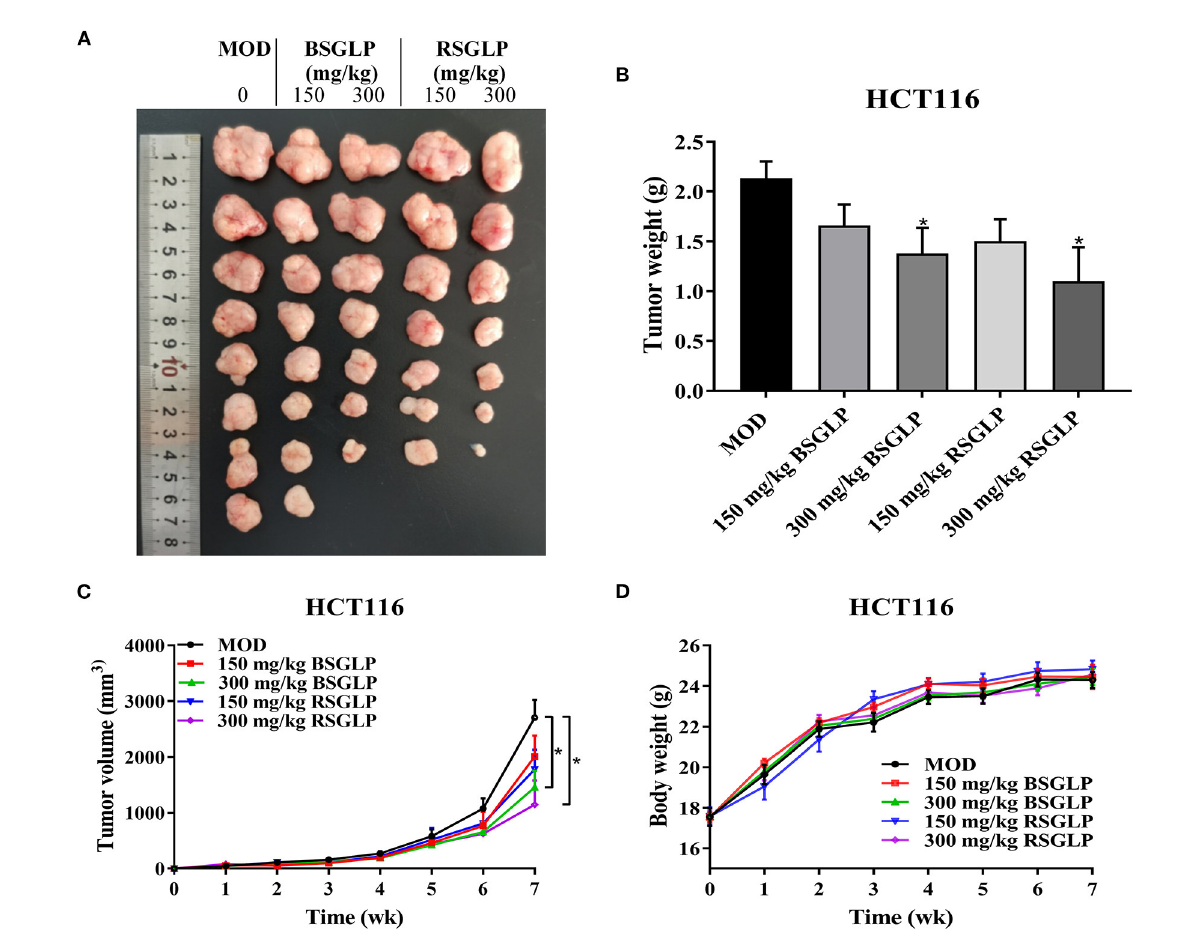
FIGURE5 Comparison of the antitumor activity of RSGLP and BSGLP in HCT116 xenograft nude mice. (A) Image of the tumor samples from each group. (B) Final tumor weight of each group. (C) Growth curve of tumor volume of each group. (D) Body weight of each group. HCT116 xenograft nude mice were treated with saline (Con and MOD), BSGLP and RSGLP (150 and 300 mg/kg) for 7 wk. All values are presented as the mean ± SE ( n = 7–8). * p < 0.05, compared with MOD